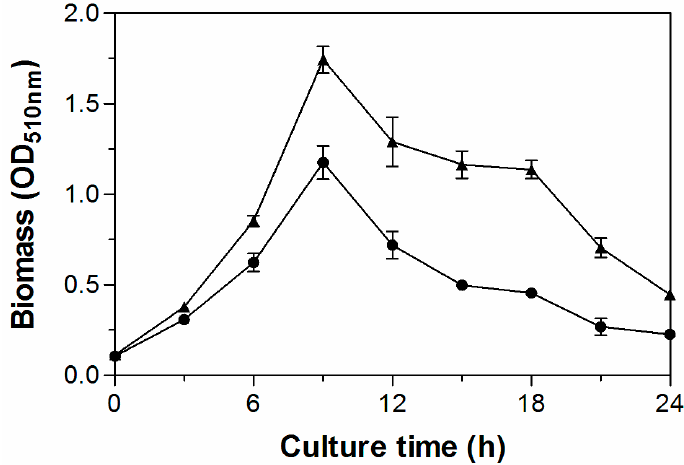
Figure 3. The growth curve of Bacillus mucilaginosus in the nutrient broth with biochar-adsorbed cells ( ▲ ) or free cells ( ● ) as inoculum.